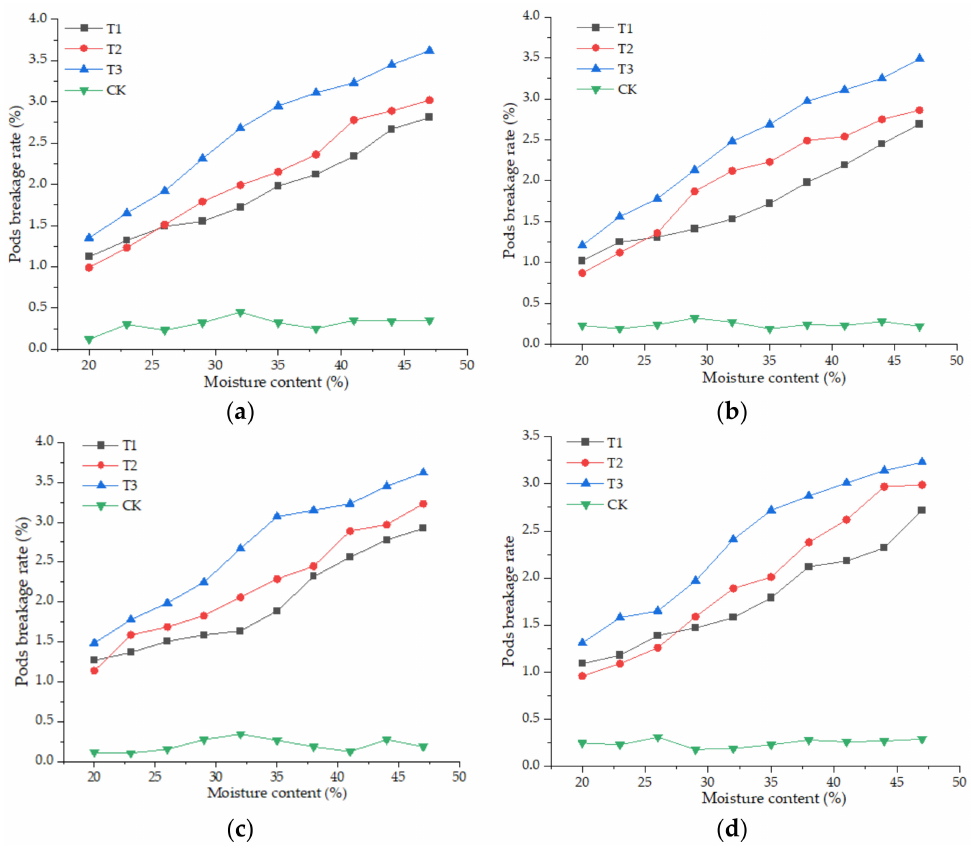
Figure 10. Test curve of pod crushed rate for two kinds of peanuts: ( a ) 2020 Shanhua 9; ( b ) 2021 Huayu22; ( c ) 2021 Shanhua 9; ( d ) 2021